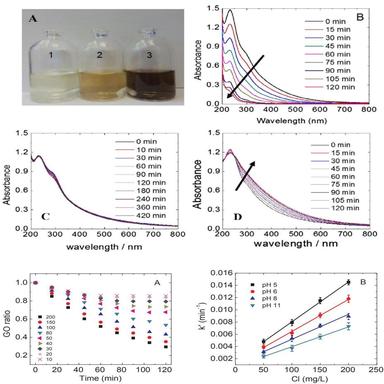
UV–vis spectra and photo of graphene oxide in UV/free chlorine system. 1A(1) and 1B: GO (50 mg/L) with 200 mg/L free chlorine at pH 5 under UV irradiation (2000 µW/cm2 ) for 2 h. 1A(2) and 1C: GO (50 mg/L) with 200 mg/L free chlorine in dark. 1A(3) and 1D: GO (50 mg/L) under UV irradiation (2000 µW/cm2 ).